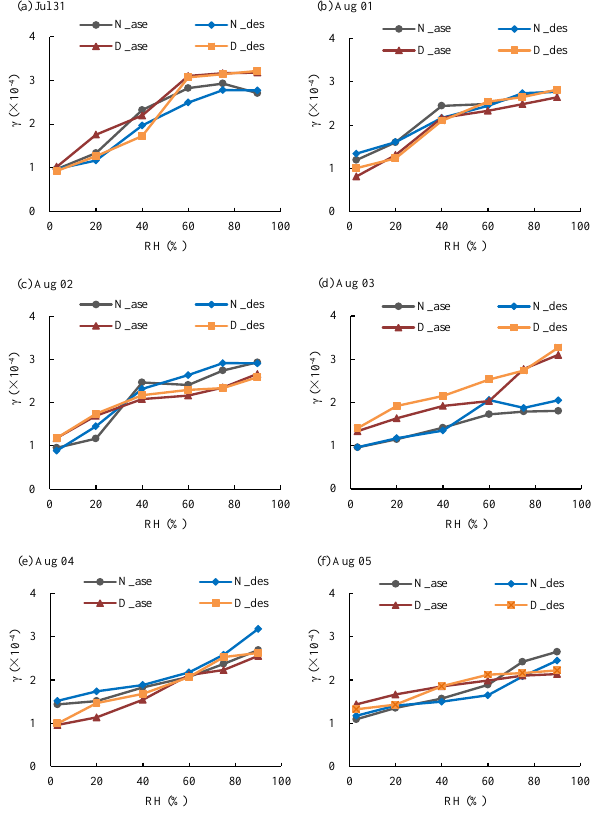
centrations of elements and soluble ions in PM 2 . 5 samples. The results are shown in Table 5. The concentration of min- eral dust was estimated by multiplying 14.3 by the concen- tration of the Al element; the ratio was suggested by Zhang et Figure 5. Profiles of uptake coefficient of gaseous H 2 O 2 on PM 2 . 5 al. (2013) for PM 2 . 5 in urban Beijing. The estimated mineral over a range of RH (3–90%); N_ase, γ H was measured with as- 2 O 2 dust accounts for 6.0 ± 4.3 and 6.2 ± 3.1 % of PM 2 . 5 mass cending RH on nighttime PM 2 . 5 particles; N_des, γ H was mea- 2 O 2 concentration on haze days and non-haze days, respectively. sured with descending RH on nighttime PM 2 . 5 particles; D_ase, γ H was measured with ascending RH on daytime PM 2 . 5 parti- The concentration of SO 2 − is 42.26 ± 7.88 µg m − 3 on haze 2 O 2 4 cles; D_des, γ H was measured with descending RH on daytime days, which is about 7 times that on non-haze days. The con- 2 O 2 PM 2 . 5 particles. centrations of NO − and Cl − on haze days are also about 3